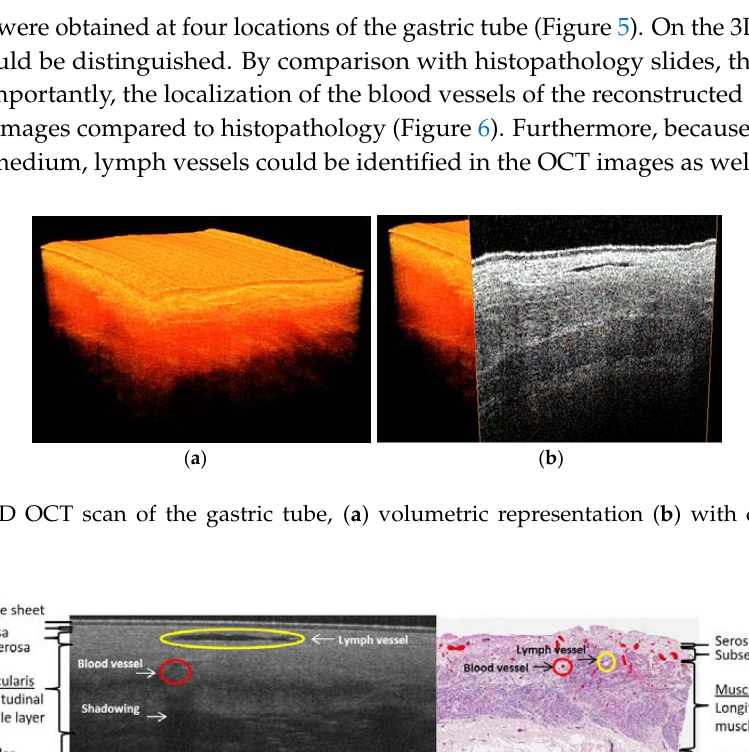
Figure 6. OCT B ‐ scan of location 4, the fundus (at the left panel), and HE stained histology slide (the right panel) obtained at the end of the gastric tube. Blood and lymph vessels are indicated in red and yellow, respectively. The corresponding tissue layers, serosa, subserosa (purple/dark pink) and muscularis propria (light pink) are depicted in both panels. The scale bar depicts a length of 1 mm.